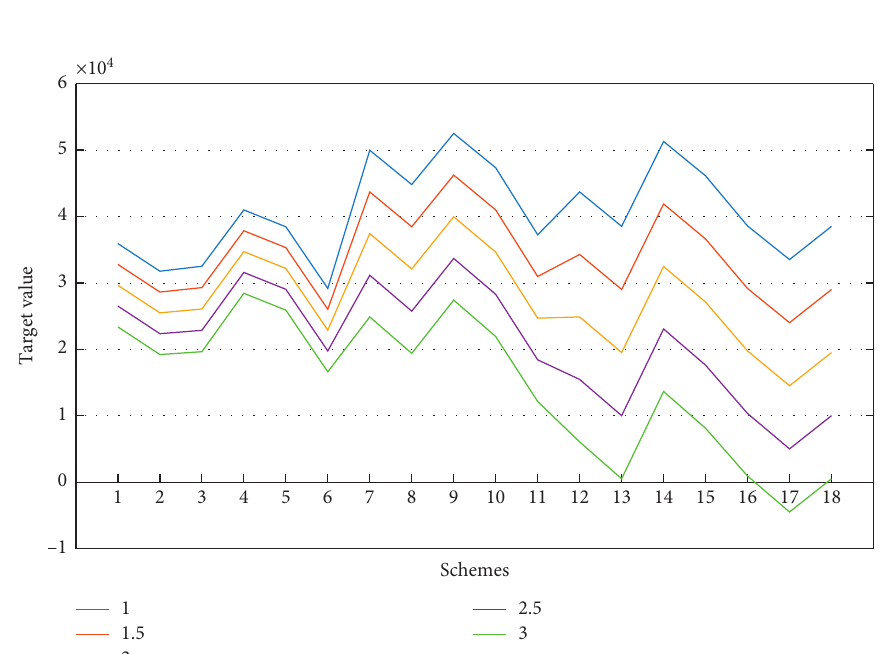
Figure 6: Costs of each